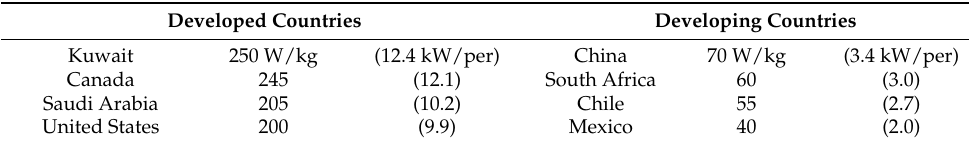
Table 1. Energy rate densities, Φ m , for selected nations as of